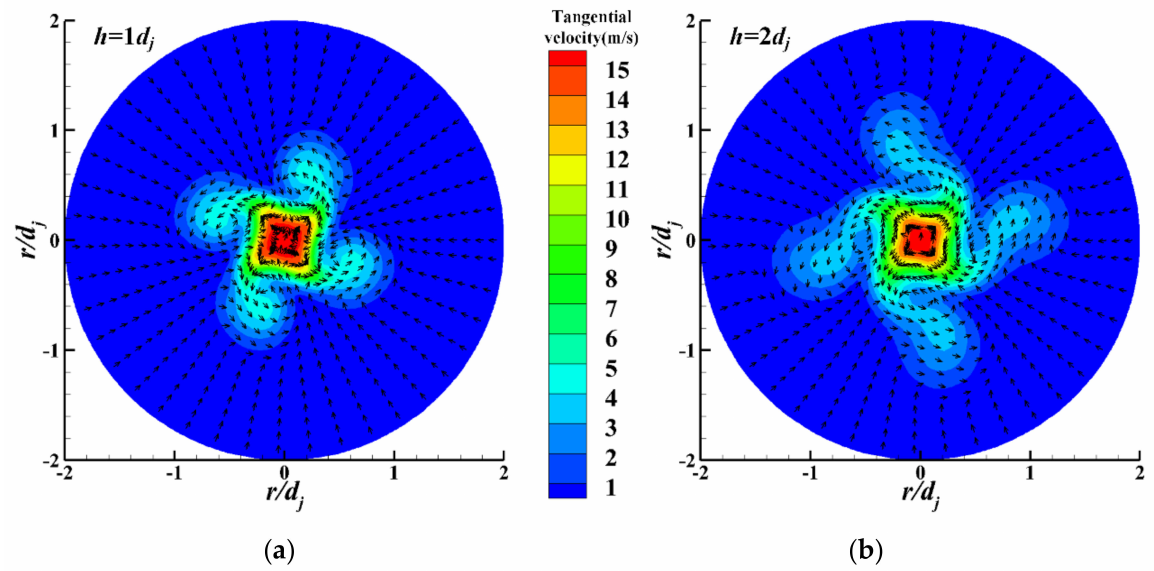
Figure 8. Tangential velocity vector at the outlet of the nozzle ( Re = 4000, SIJ 45 ◦ ) for ( a ) h = d j , and ( b ) h = 2 d j . Figure 7c is the tangential velocity contour in the x = 0 section. The peak position shows an oscillating behavior, increases from h = 0 to h = 1 d j , decreases up to h = 3 d j